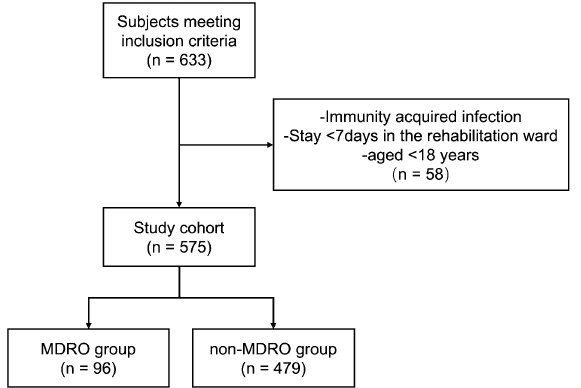
Figure 1. Patient enrollment flow